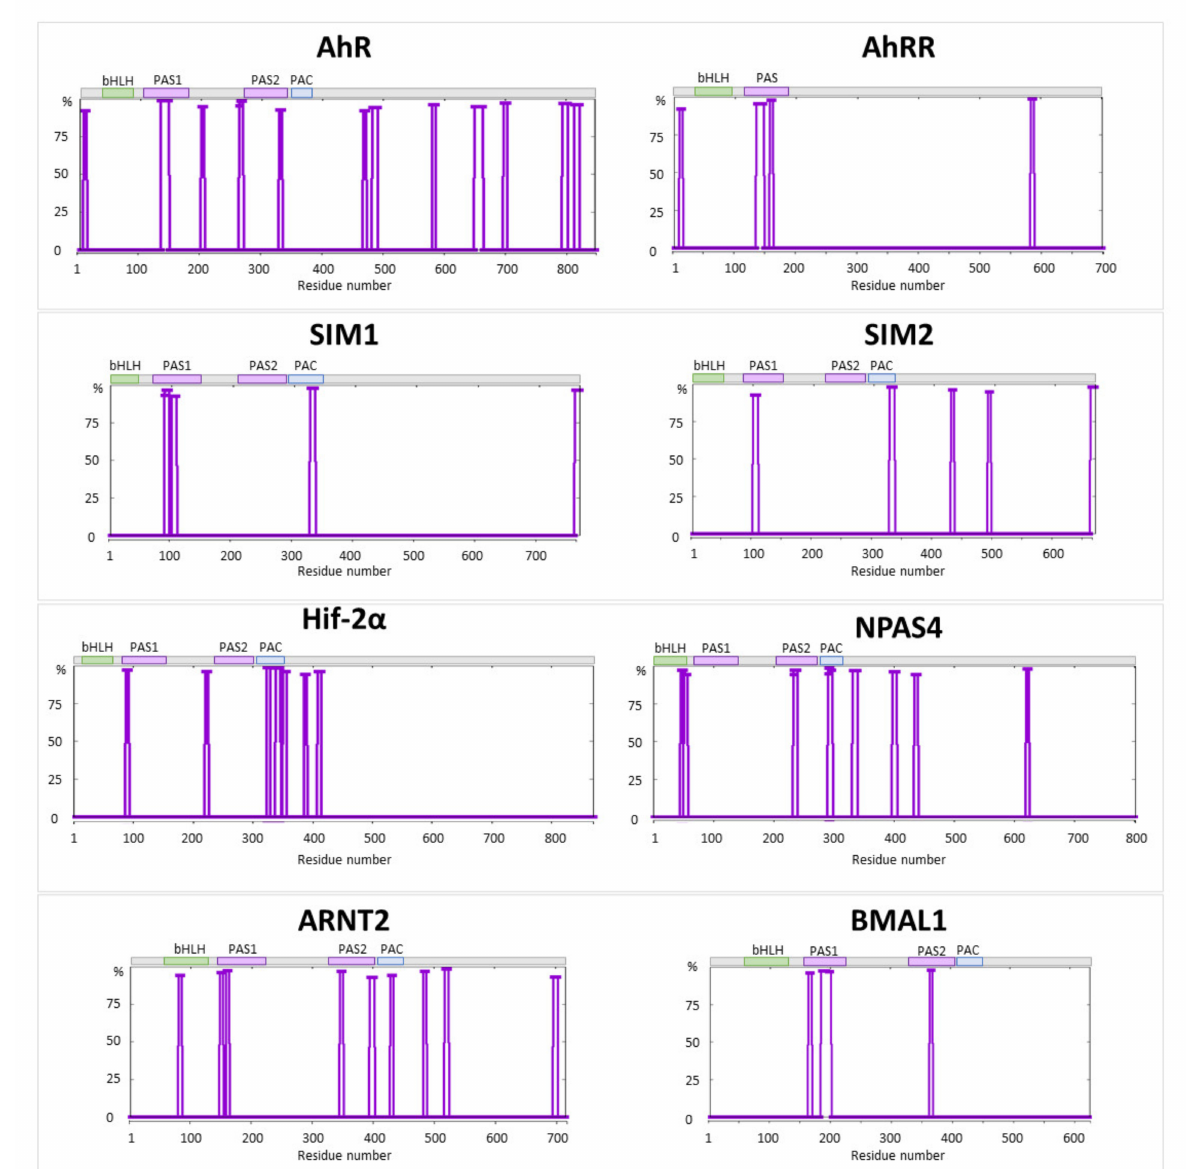
Figure 6. In silico prediction of amylogenic regions for AhR, AhRR, SIM1, SIM2, Hif-2 α , NPAS4, ARNT2, and BMAL1 using Waltz predictor